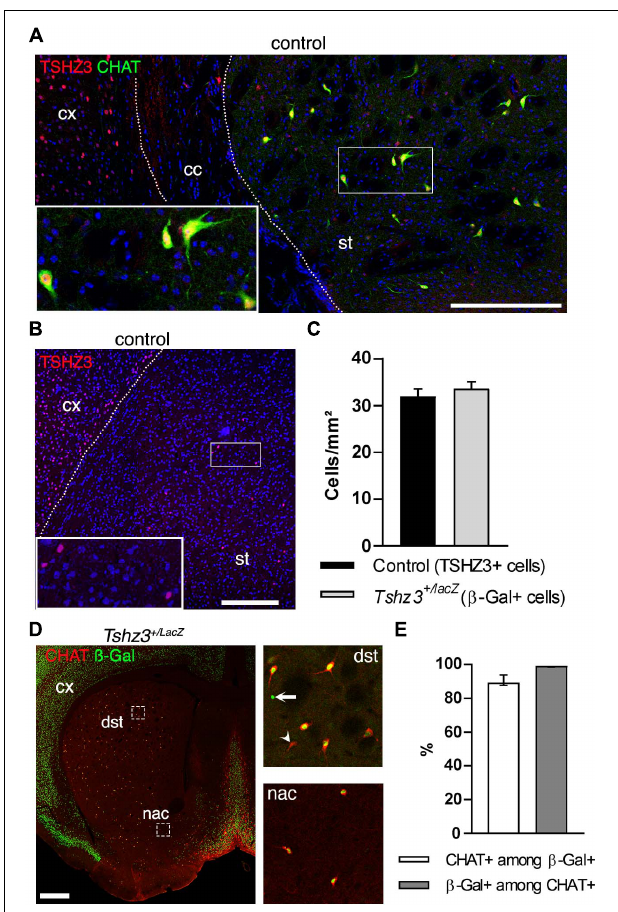
FIGURE 1 | TSHZ3 is expressed in SCINs. (A) Immunostaining in a control mouse showing the expression of TSHZ3 and CHAT that identifies SCINs. Scale bar, 200 µ m. (B) Immunostaining showing the expression of TSHZ3 in a control mouse. Scale bar, 250 µ m. (C) Density of TSHZ3-positive (1791 cells in 56.0 mm 2 from eight control mice) and ß-Gal-positive (954 cells in 28.1 mm 2 from four Tshz3 + / LacZ mice) striatal cells ( P = 0.5225, Student’s t -test; data are expressed as mean + SEM). (D) Immunostaining showing the expression of ß-Gal (TSHZ3) and CHAT. Scale bar, 500 µ m. Framed regions are shown on the right; arrow shows a ß-Gal-positive/CHAT-negative cell; arrowhead shows a CHAT-positive/ß-Gal-negative cell. (E) Percentage of CHAT-positive cells among ß-Gal-positive (TSHZ3+) cells, and vice-versa (12 sections from four Tshz3 + / LacZ mice; data are expressed as median with interquartile range). cc, corpus callosum; cx, cerebral cortex; st, striatum. Nuclei in A,B are counterstained with DAPI (blue).